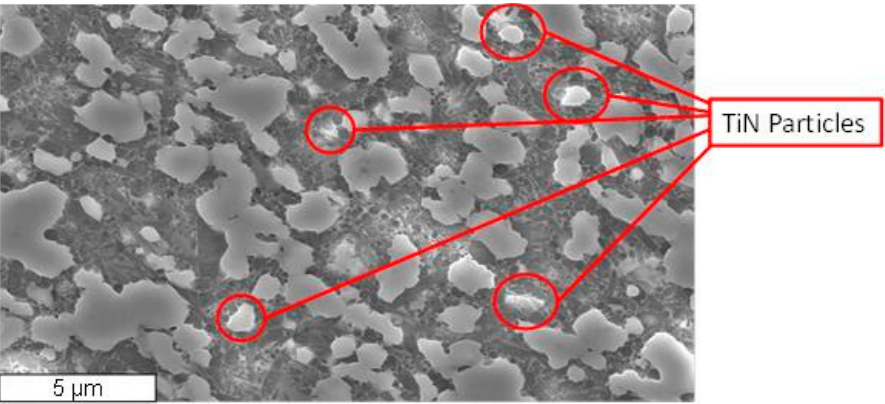
Figure 1. SEM micrograph of a mirror polished and plasma-etched surface of the Si 3 N 4 -35 vol% composite: dark grains are Si 3 N 4 particles, while coarser, light grey grains are TiN particles.